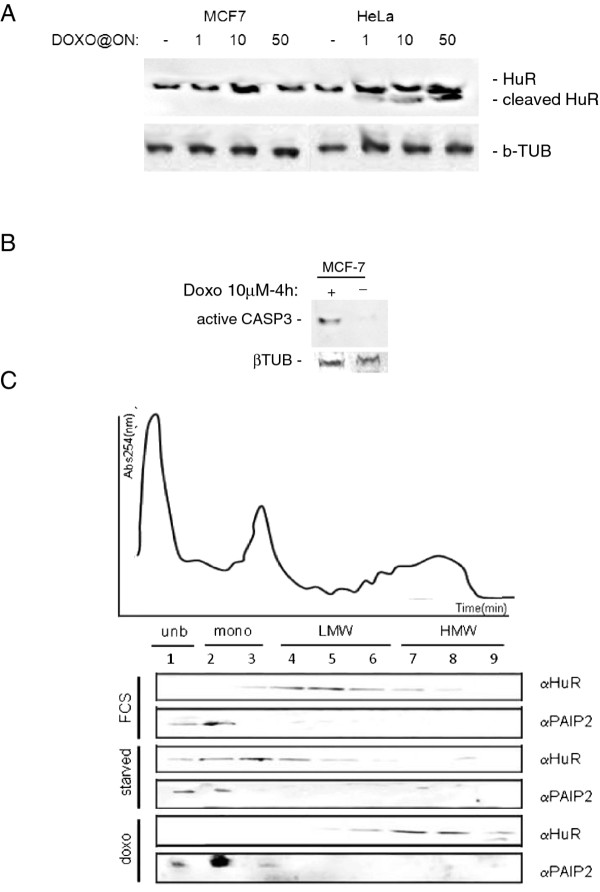
A: HuR apoptotic cleavage is not present in MCF-7 cells. Western blotting analysis on HeLa and MCF-7 whole cell lysate sampled after an overnight exposure to doxo at different doses 1, 10, 50 μM (+) or not (-). The cleaved form is present in HeLa cells but only in minimal part in MCF-7 cells. B: Active caspase 3 is present in MCF-7 cells. Western blotting analysis on HeLa and MCF-7 whole cell lysate sampled after an overnight exposure to doxorubicine 10 μM (+) or not (-). Active caspase 3 is present in MCF-7 cells. C: HuR translocates onto the translational active polyribosomes. Western blotting analysis on polysomal fractionation samples (1-9). Fractionation was performed on MCF-7 cells grown in standard condition (FCS), starved or treated with doxorubicin 10 μM for 4 h and samples were investigated for the presence of HuR or PAIP2. In the upper part of the panel is reported a polysomal profile indicating which fractions are enriched in unbound ribosomes (unb), single ribosomes (mono), low molecular weight polysomes (LMW) or high molecular weight polysomes (HMW). The HMW are the fractions where the translational active polyribosomes sedimentate and the HuR western bloltting signal after doxorubicin treatment localizes. PAIP2 is used as control since localization is not affected.